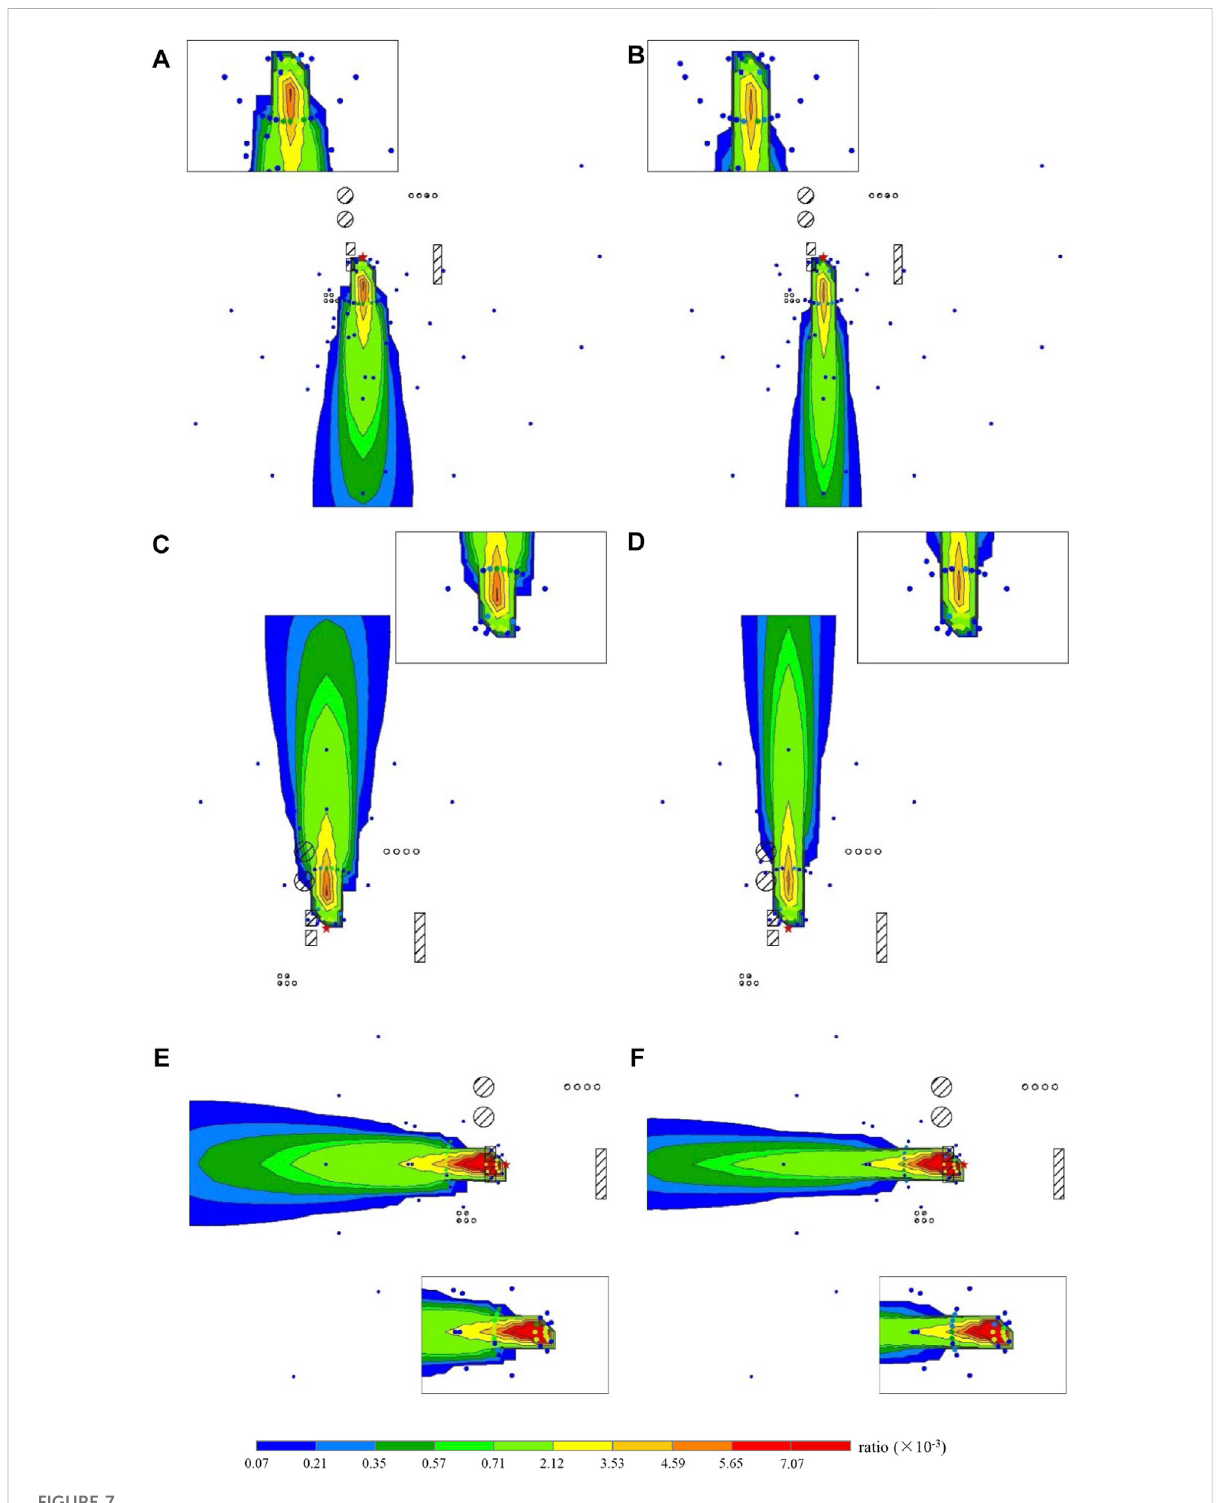
FIGURE 7 Overlaid comparison diagrams of wind tunnel observation and CALPUFF simulation results: (A) N direction, 3 m/s, (B) N direction, 6 m/s, (C) S direction, 3 m/s, (D) S direction, 6 m/s, (E) E direction, 3 m/s, and (F) E direction, 6